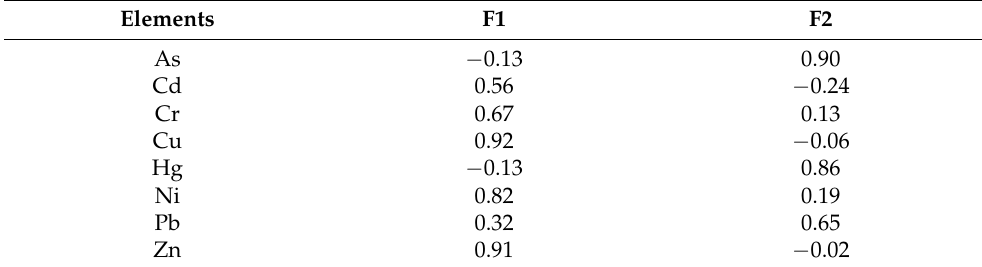
Table 7. Rotated matrix of factor analysis